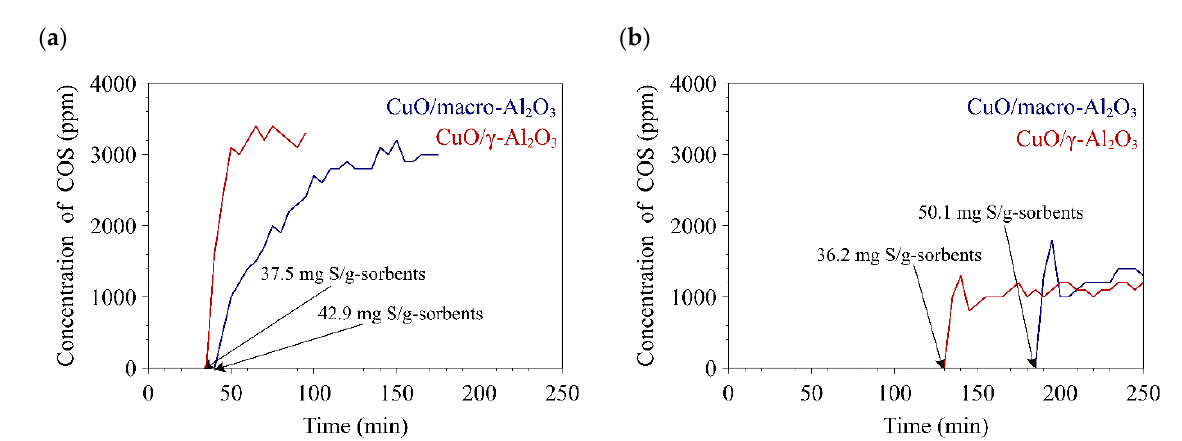
Figure 9. COS breakthrough curves by the desulfurization tests over ( a ) powder type and ( b ) pellet type of 15 wt %